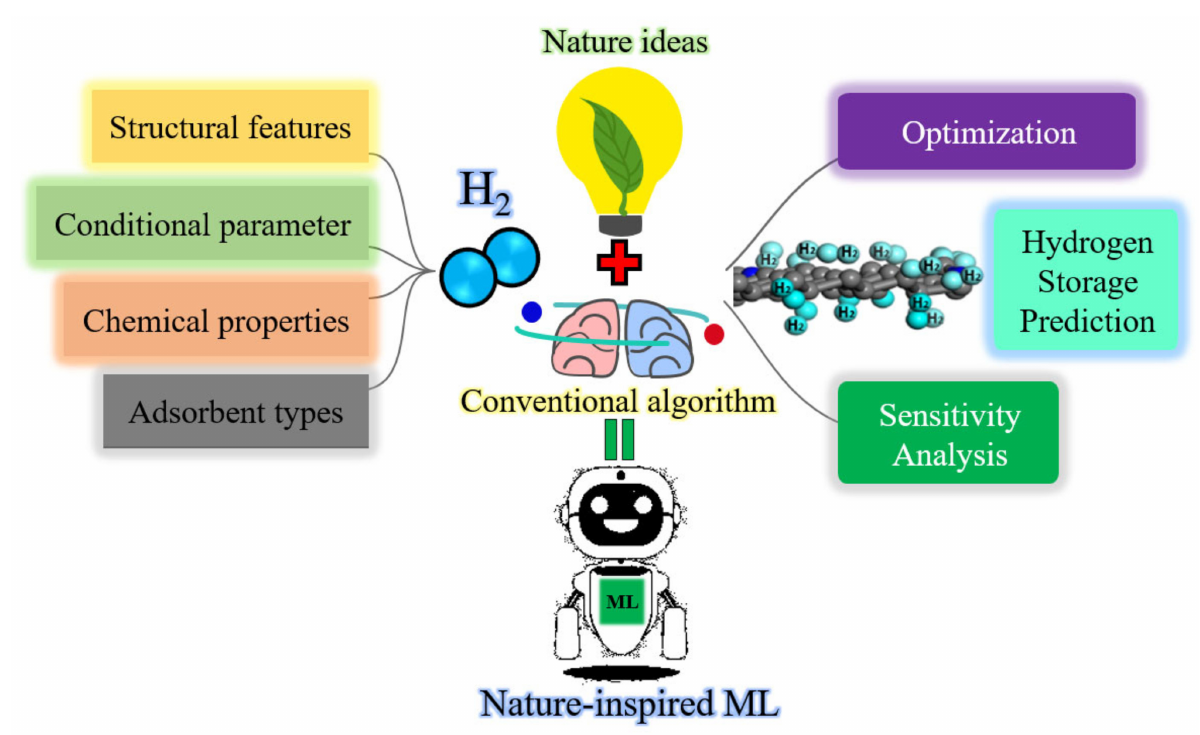
Figure 1. Nature-inspired algorithms in ML for hydrogen storage